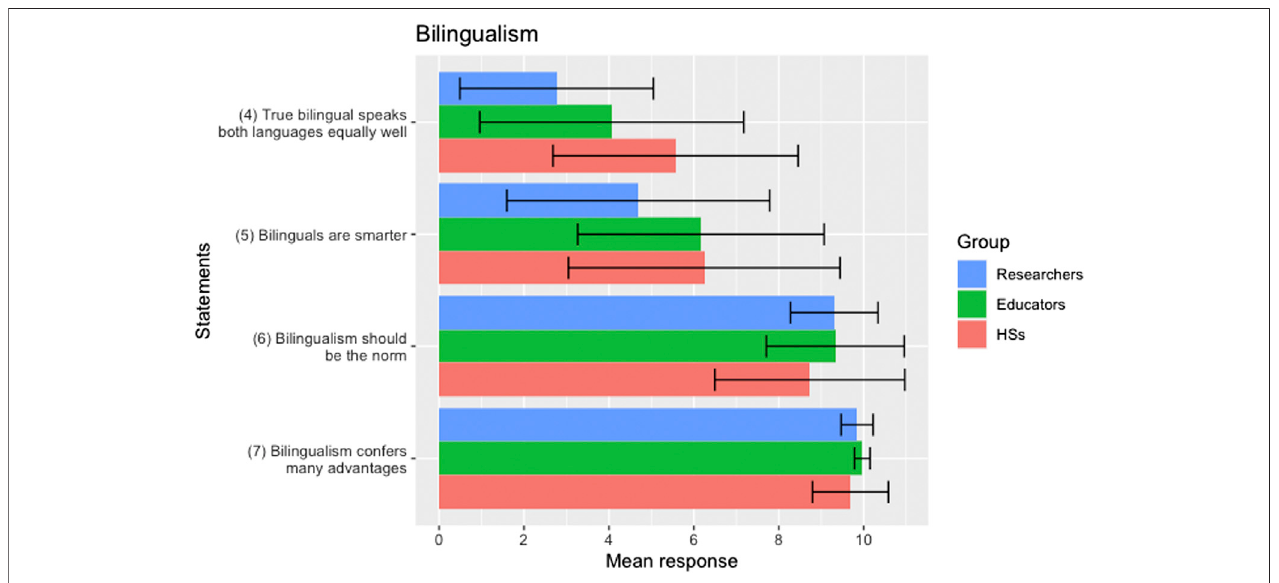
FIGURE 1 | Summary of the responses for questions related to Bilingualism for HSs, Educators, and Researchers. Note: Participant responses are reported on a scale from 0 “ Strongly Disagree ” to 10 “ Strongly Agree. ”